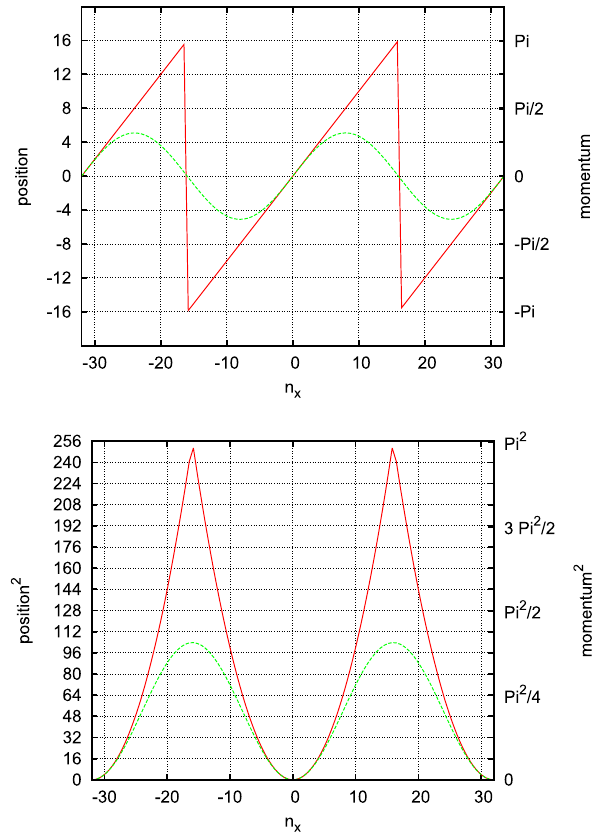
Fig. 2 Top panel: periodic x -component of the distance vector x (left verticalaxis)andthemomentumvector k (rightverticalaxis),asappears in the numerator of the JIMWLK kernel. The naive/sine discretization is shown in red/green. Bottom panel: analogously for the squares of the distance and momentum vectors, corresponding to the denominator of the JIMWLK kernel. The lattice size is L / a =